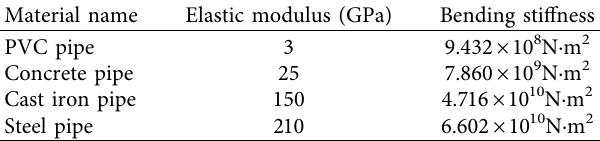
Table 1: Material parameters of different pipelines.